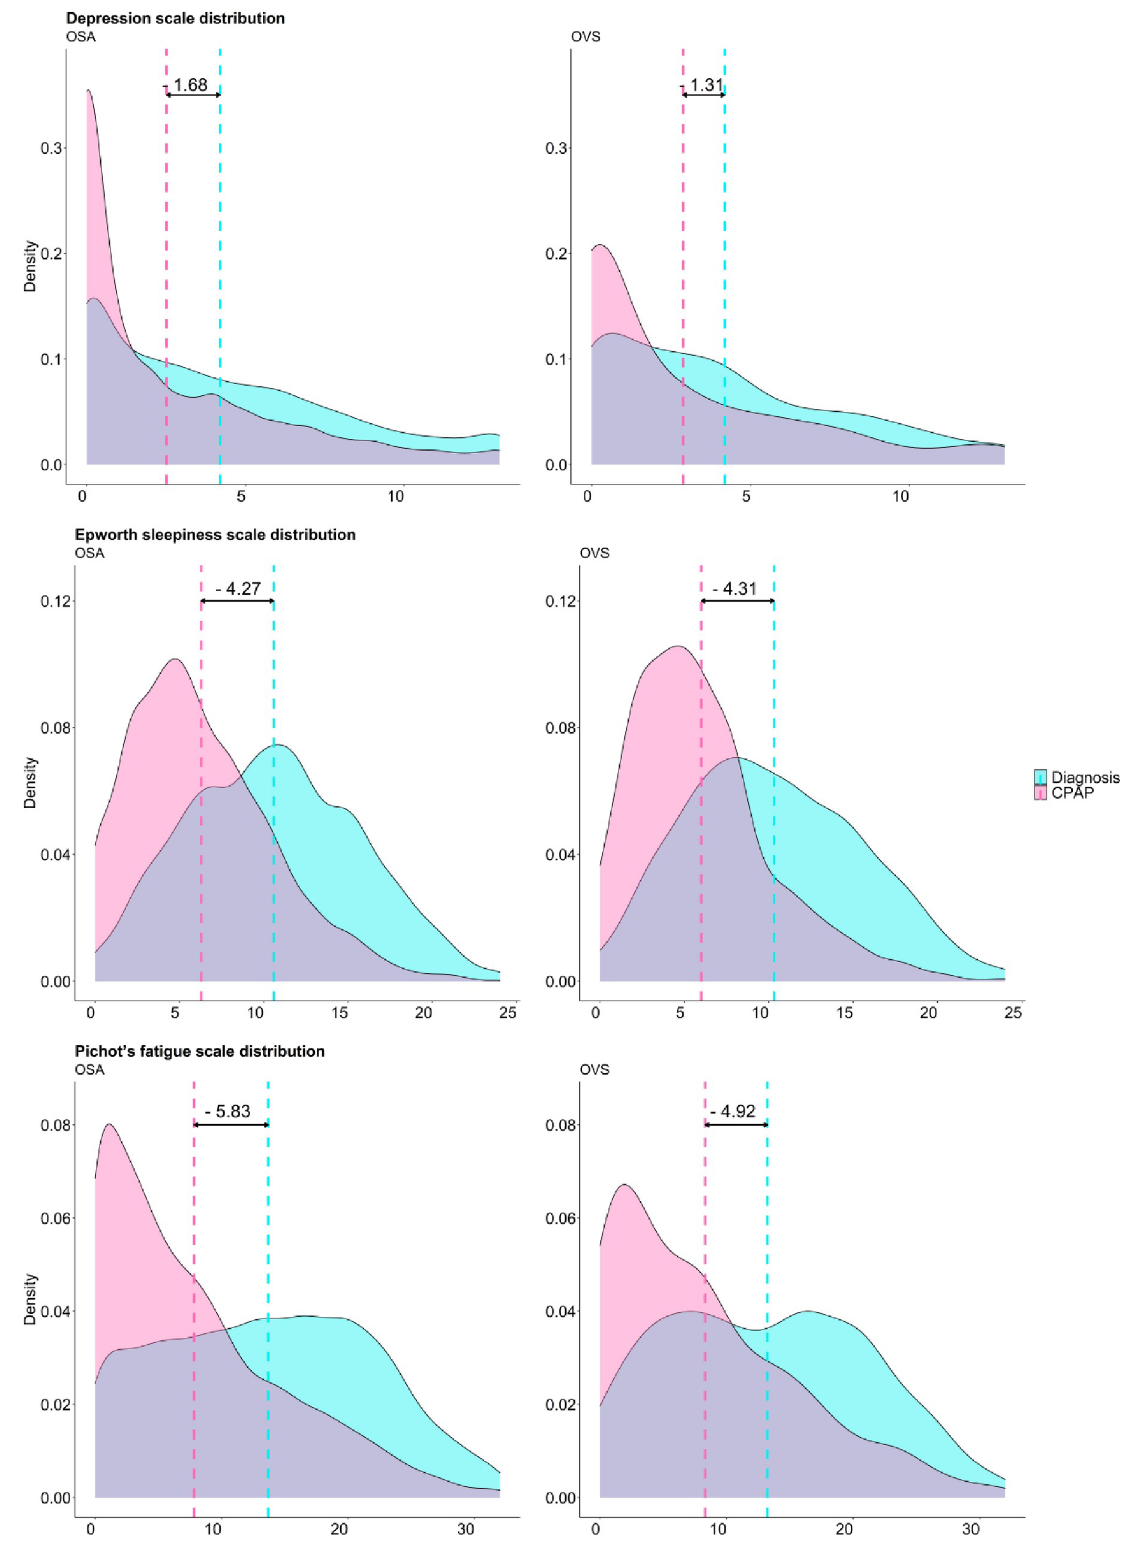
Fig 2. Distribution of Depression scale, ESS and Pichot’s fatigue scale at baseline (blue) and follow-up visit (pink) in OSA patients (left) and OVS patients (right). The scattered line represents median value. The difference between both scattered lines represent the effect of CPAP